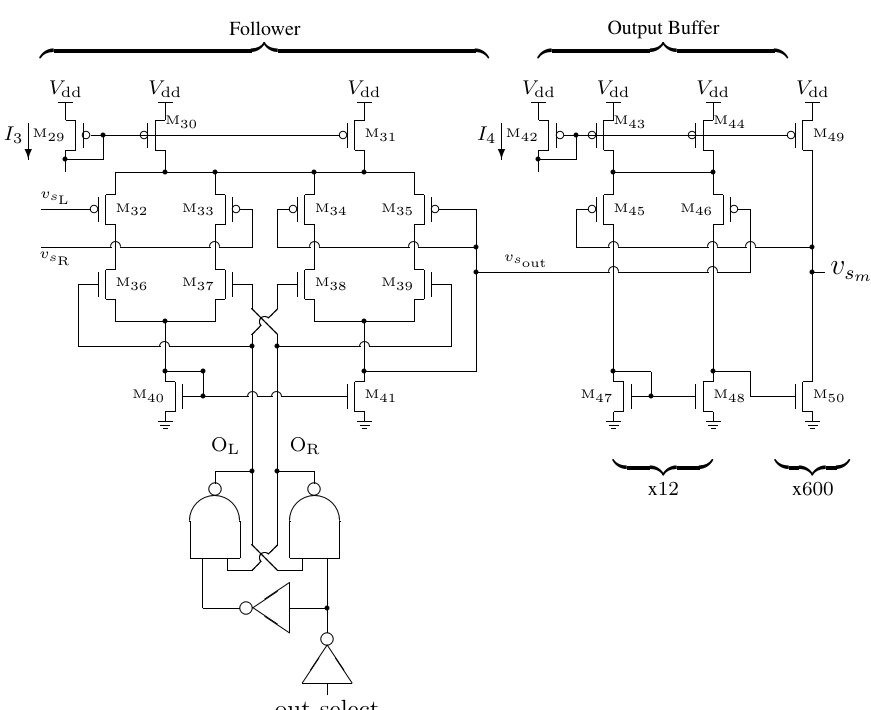
Figure 8. Two-input follower and output buffer circuit